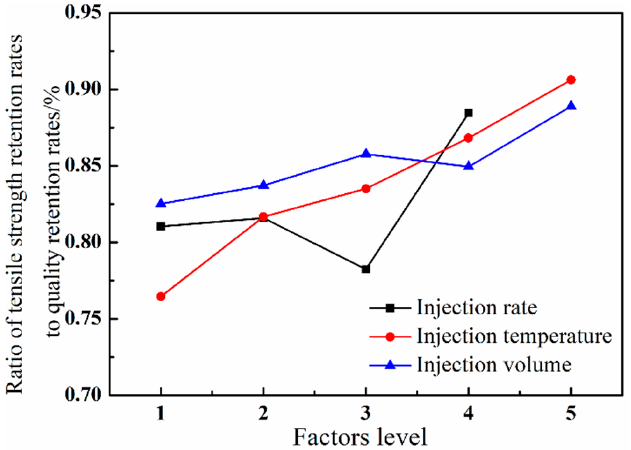
Figure 6. The ratio of tensile strength retention rates to quality retention rates of GF / PA foams at different factor levels.